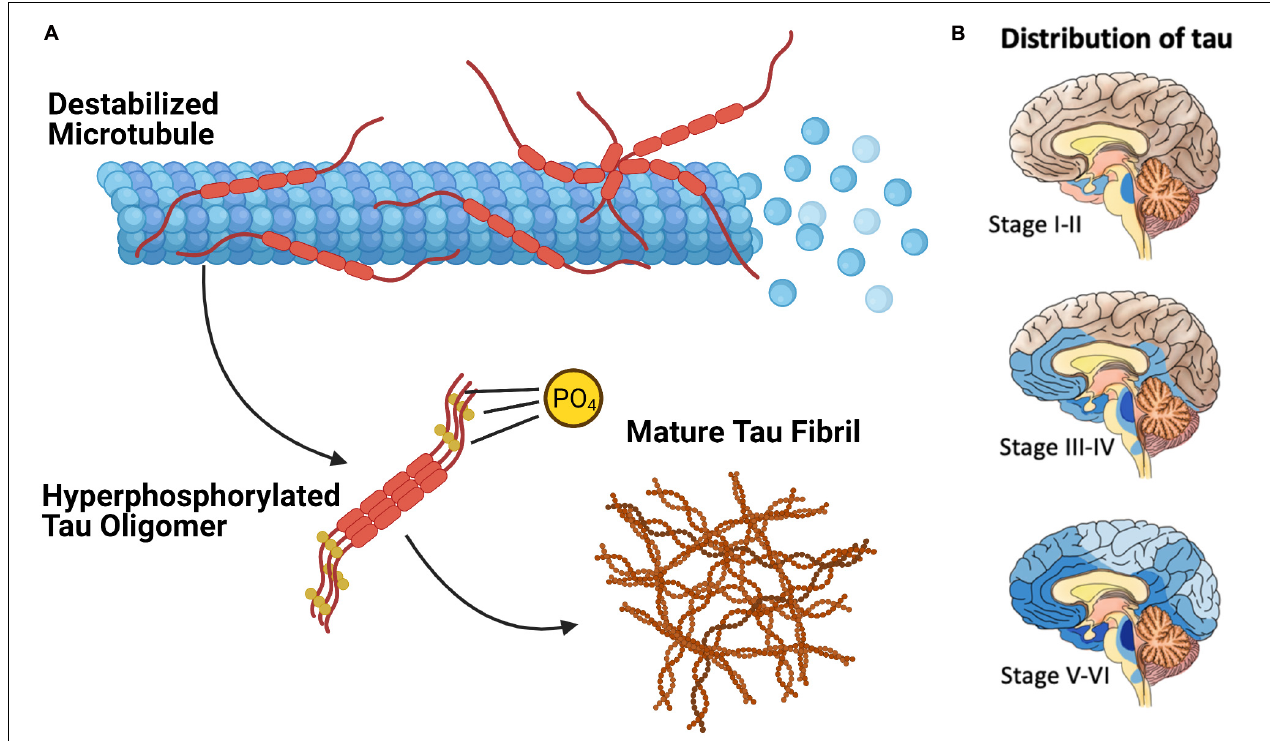
FIGURE 2 | The Pathological Deposition of Tau Protein in Alzheimer’s Disease. (A) The Phosphorylation (denoted with “P”) of tau protein is associated with the destabilization of the tau microtubule complex and the assembly of tau protein into higher order aggregates. (B) Mature tau fibrils (in blue, darker color denotes greater fibril density) spreads throughout the brain of AD patients in discrete stages which resembles the progression of communicable prion diseases.